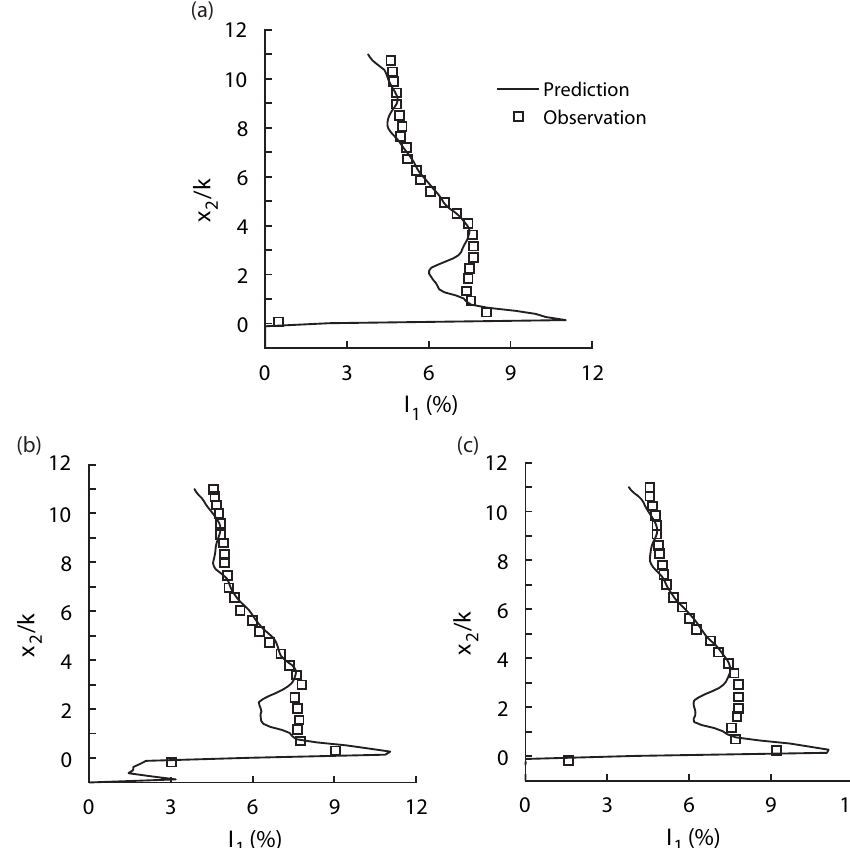
Figure 10. Vertical profiles of predicted turbulence intensity component I 1 in the streamwise direction for Run 1, compared with observed values [13]. Panels ( a – c ) correspond, in locations, to those in Figure 5.